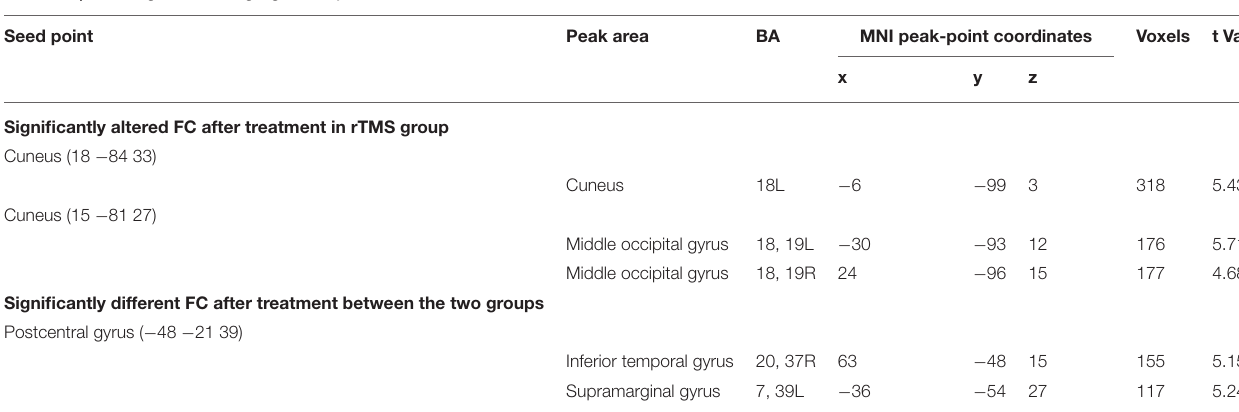
TABLE 4 | Brain regions showing significantly altered